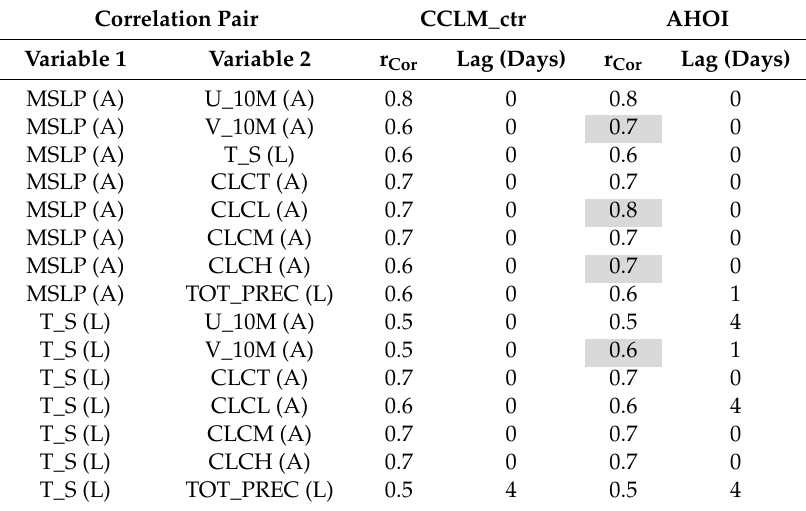
Table 3. Correlation coe ffi cient (r Cor ) of daily spread between two variables over the NS_BS domain of a) the stand-alone CCLM (CCLM_ctr) and b) AHOI for 1 September 2013–31 December 2013. (A) refers to “all points” and (L) to “land points only”. Grey boxes show the larger values of r Cor for a given pair of variables when comparing the stand-alone CCLM and AHOI if the di ff erence between them is greater or equal to 0.1. Correlation Pair CCLM_ctr